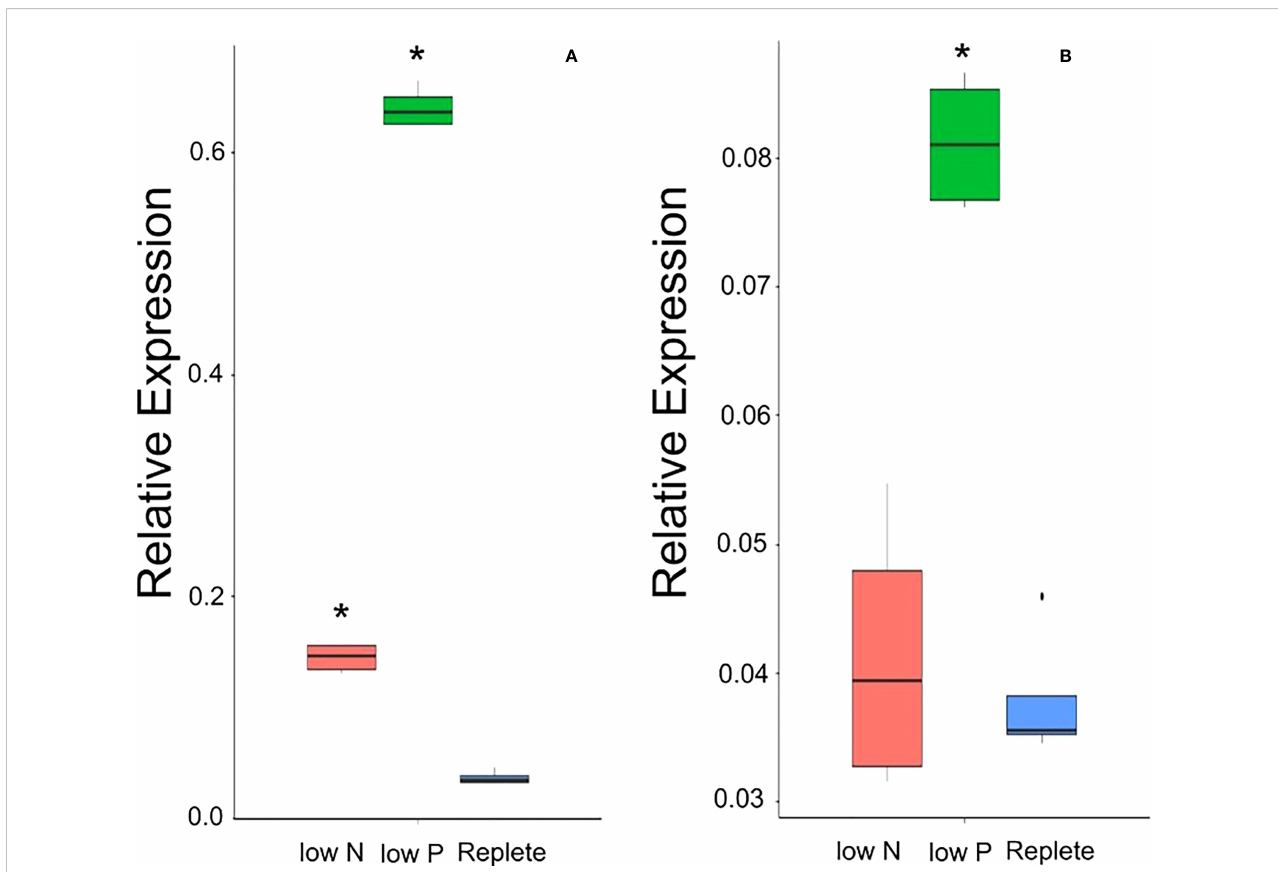
FIGURE 4 Transcript levels of OsPSTOL or TaPSTOL in the roots under different nutrient levels in rice and wheat. Expression values shown are PSTOL transcript levels relative to transcript levels of OsUbi for rice (A) and TaUbi for wheat (B) plants grown under low nitrogen (low N), low phosphate (low P) and replete nutrient levels in hydroponic solution. Data shown as the mean values (central line), lower and upper quartiles (box), minimum and maximum values (whiskers), and outliers as individual points. The statistical analysis was performed with ANOVA and post hoc Tukey test, * correspond to signi fi cant differences between transcript levels of either line under either treatment